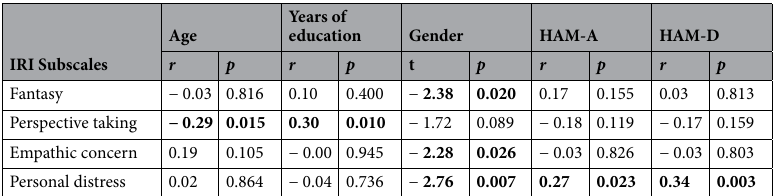
Table 2. IRI subscales and sociodemographic variables. Significant results (p < 0.05) are in Bold.